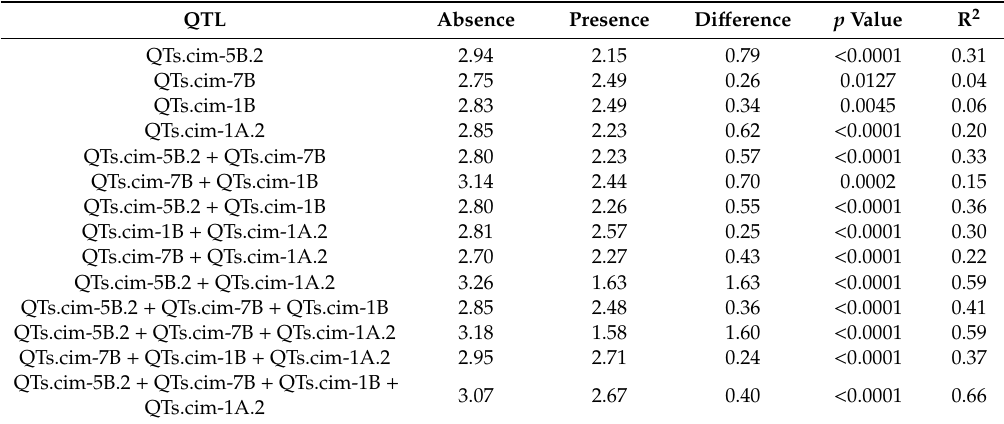
Table 5. Comparison of RILs having di ff erent tan spot